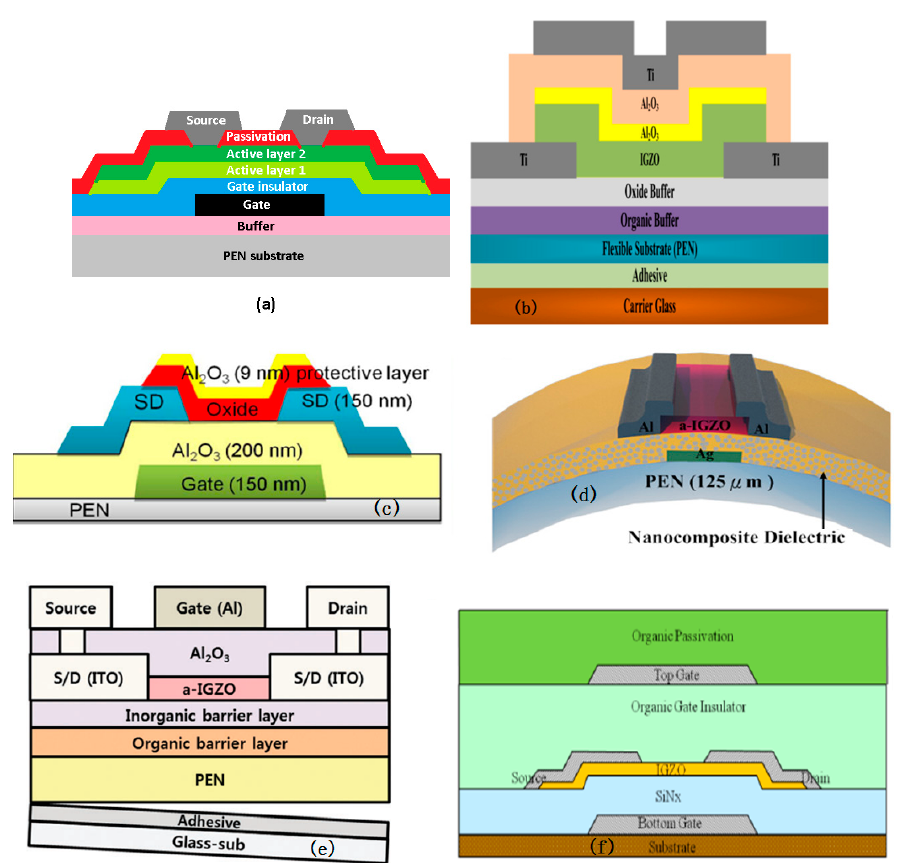
Figure 5. Schematic of the TFTs fabricated on PEN. ( a ) Dual active layer structure. ( b ) Top-gate structure [86]. ( c ) IZO:F-TFTs with fluorine-doped [124].( d ) a-IGZO TFTs with nanocomposite dielectric [49]. ( e ) A-IGZO-TFT with double-layered barrier layer structure [154]. ( f ) A-IGZO-TFT formed using a flash lamp annealing process [155].